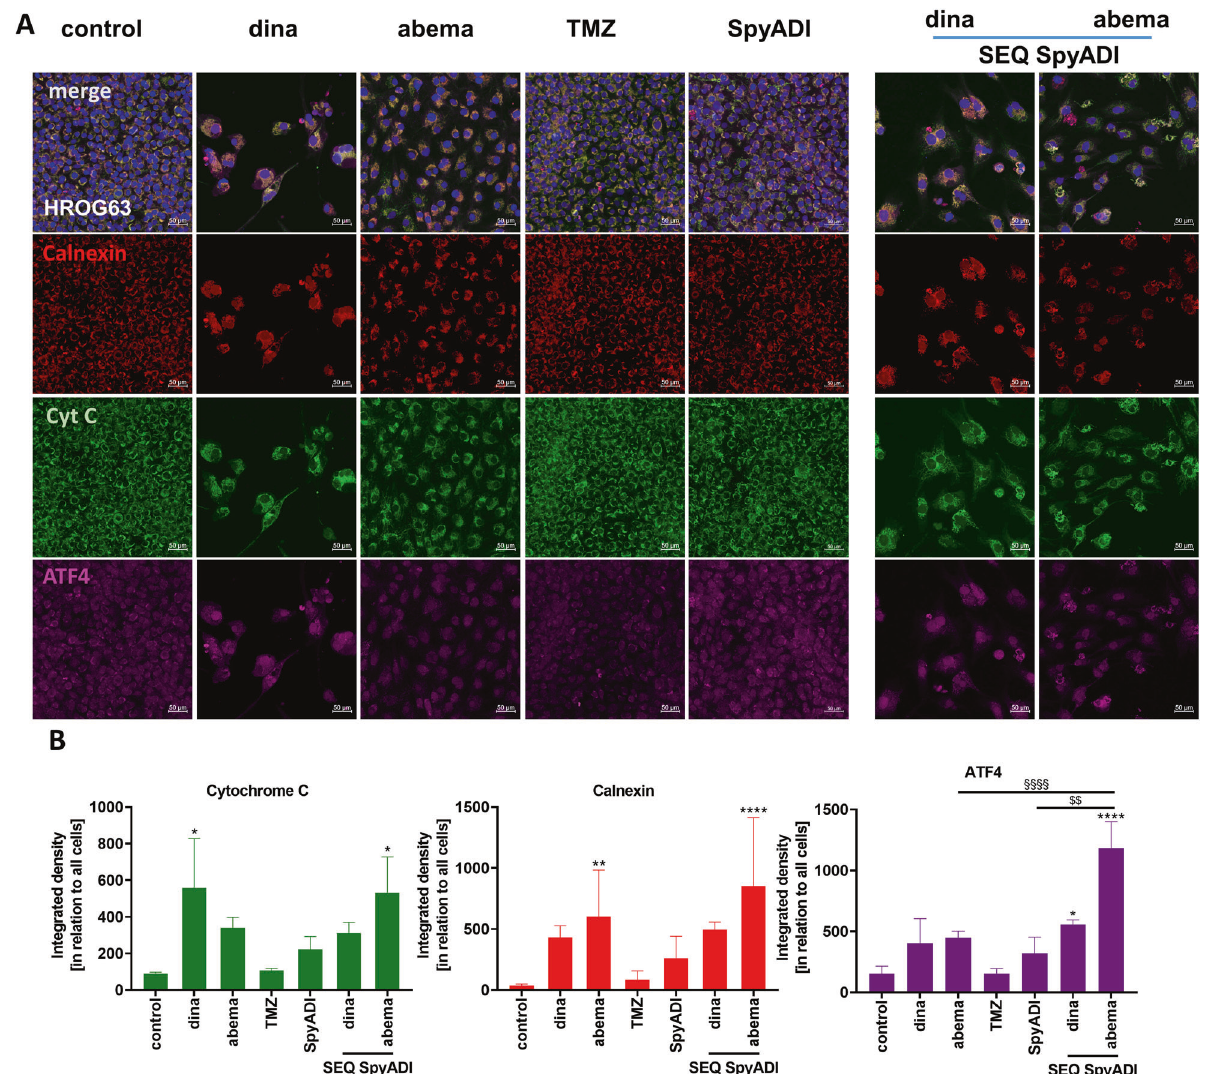
Fig. 5 Detection and quanti fi cation of cytochrome c, calnexin, and ATF-4. A GBM cells (HROG63) were stained with respective antibodies to determine the subcellular localization of cytochrome c (green), calnexin (red), ATF-4 (violet) and counterstained with DAPI to visualize nuclei (blue). CDKi-SpyADI combination resulted in minor UPR. Merged images as well as single images were taken on a Leica DMI 4000B for mitochondrial function/acidic compartment evaluation and ER-stress marker and cytochrome c localization were analyzed via a Zeiss Elyra 7 Confocal Laser Microscope. Representative images are shown. B Quanti fi cation of speci fi c markers. n = 3 independent experiments; * p < 0.05, ** p < 0.01; **** p < 0.0001; §§§§ p < 0.001; $$ p < 0.01. One-way